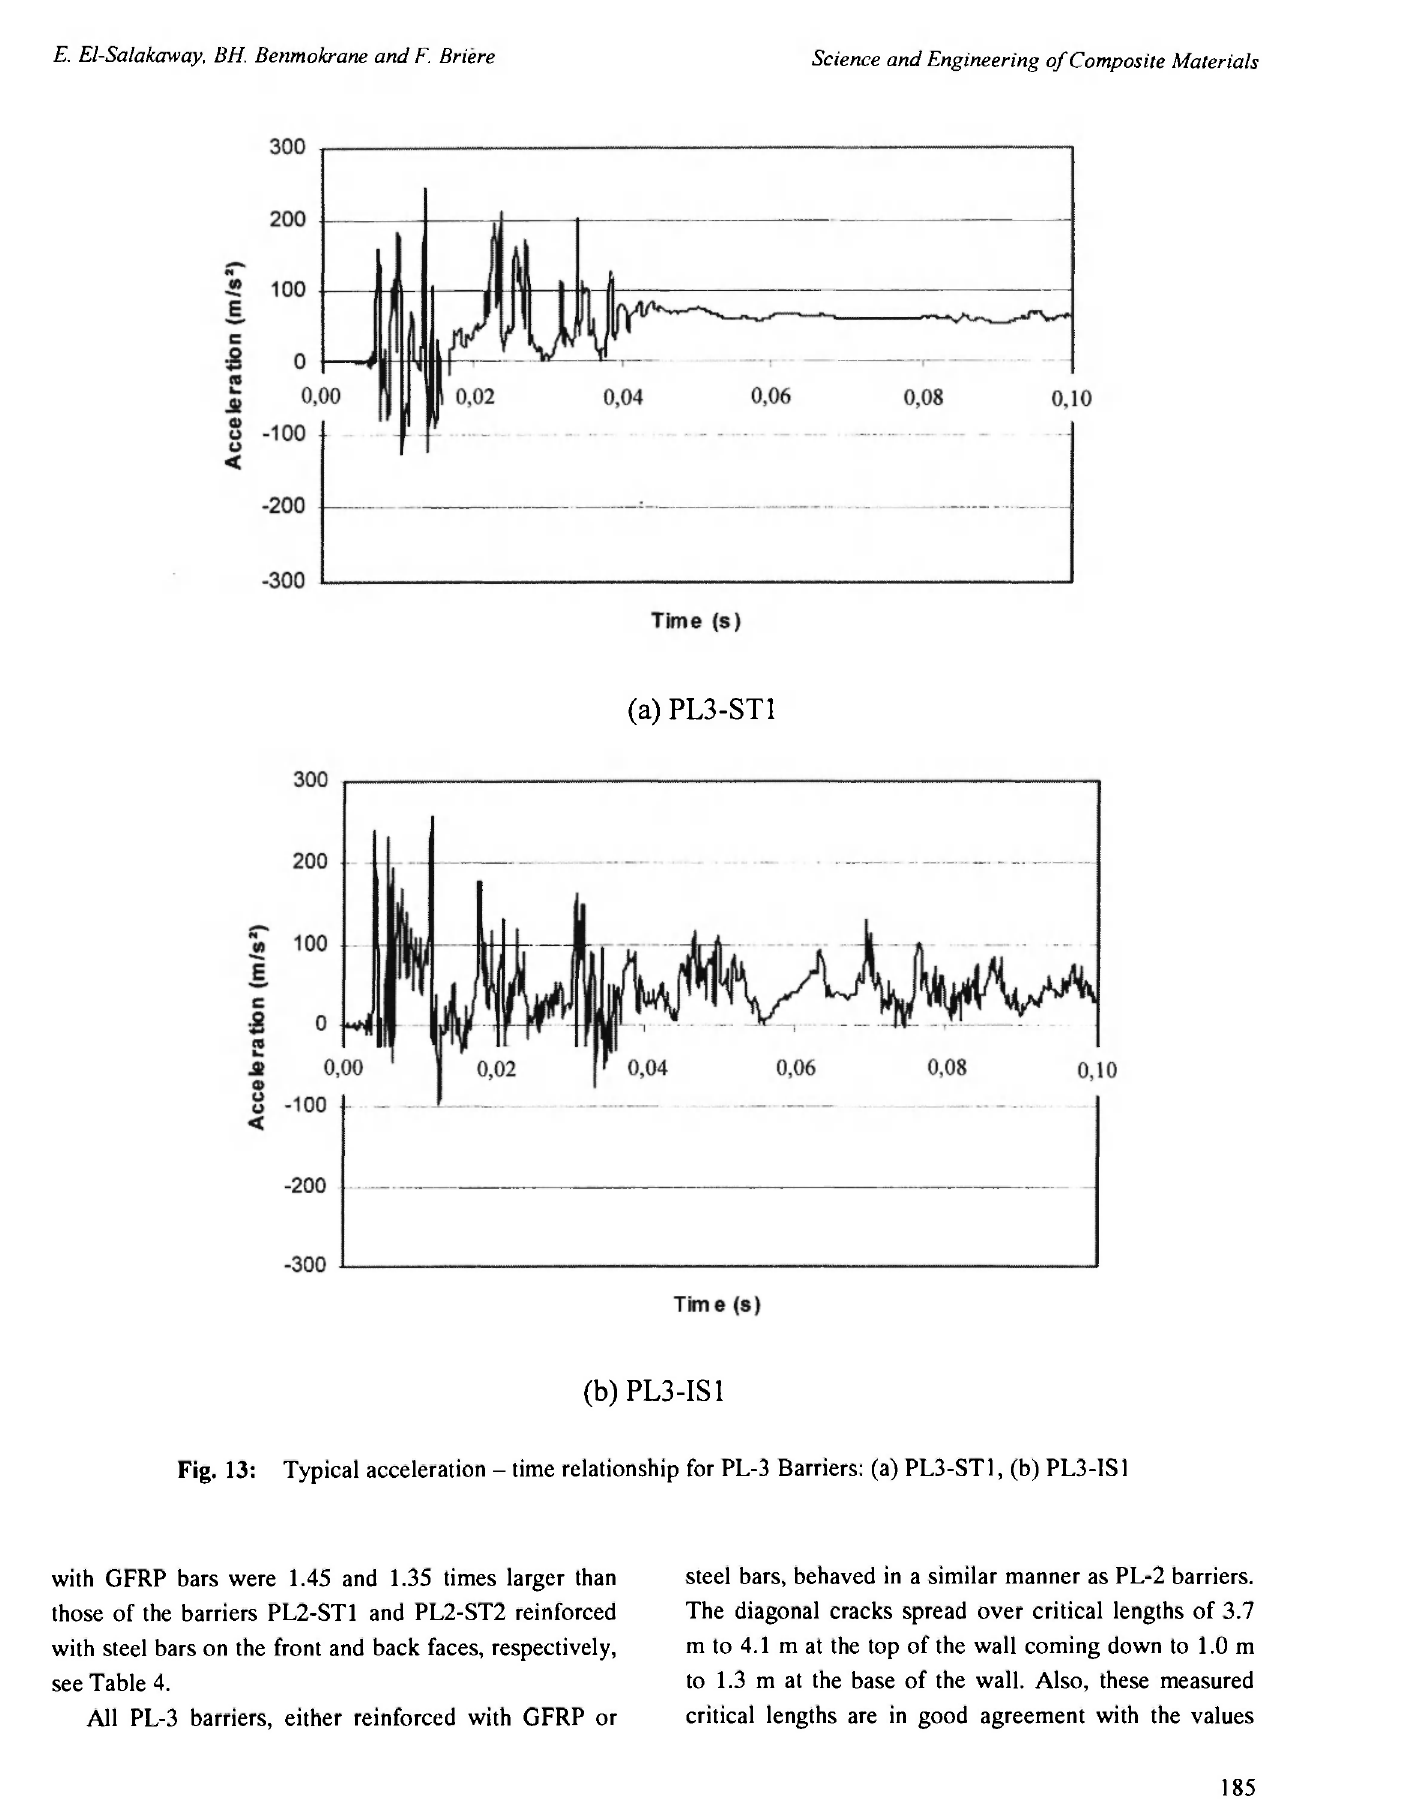
steel bars, behaved in a similar manner as PL-2 barriers. The diagonal cracks spread over critical lengths of 3.7 m to 4.1 m at the top of the wall coming down to 1.0 m to 1.3 m at the base of the wall. Also, these measured critical lengths are in good agreement with the values